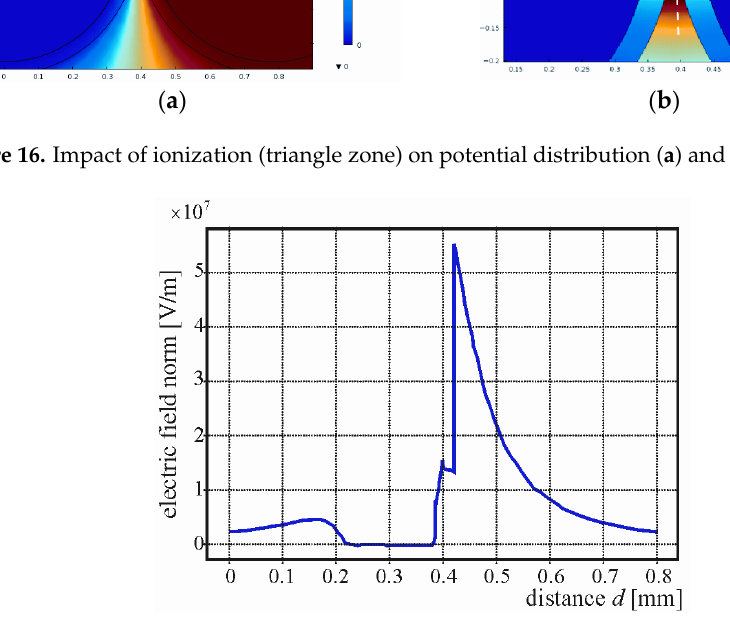
Figure 17. The electric field strength distribution in the cross ‐ section depicted in Figure 16b.